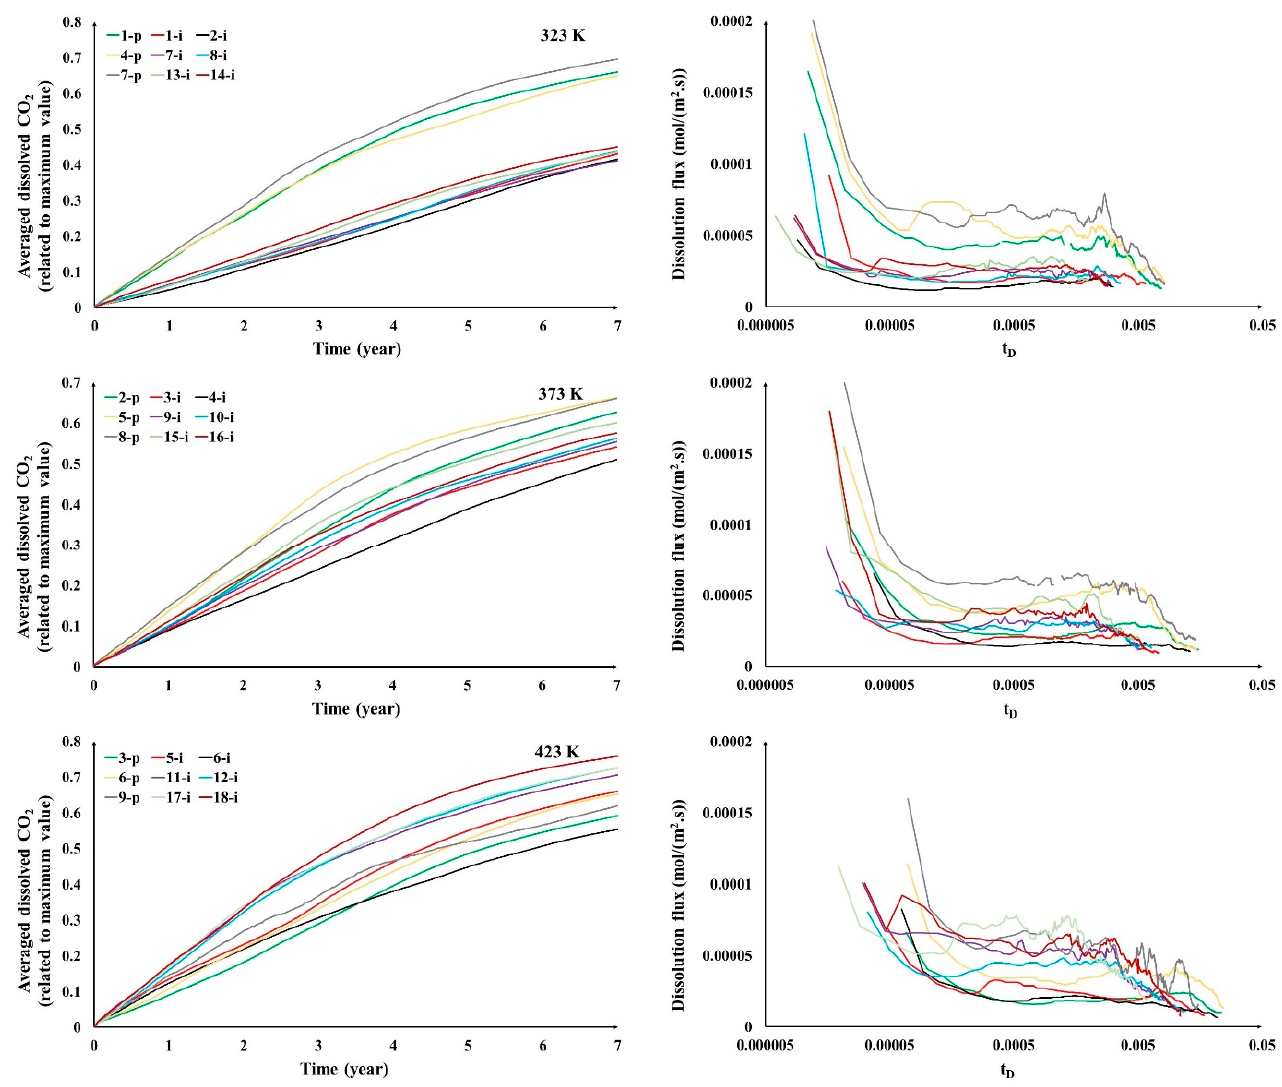
Figure 4. The averaged dissolved CO 2 and dissolution flux for pure and impure cases classified based on temperature. Legends for left- and right-hand subplots are same.